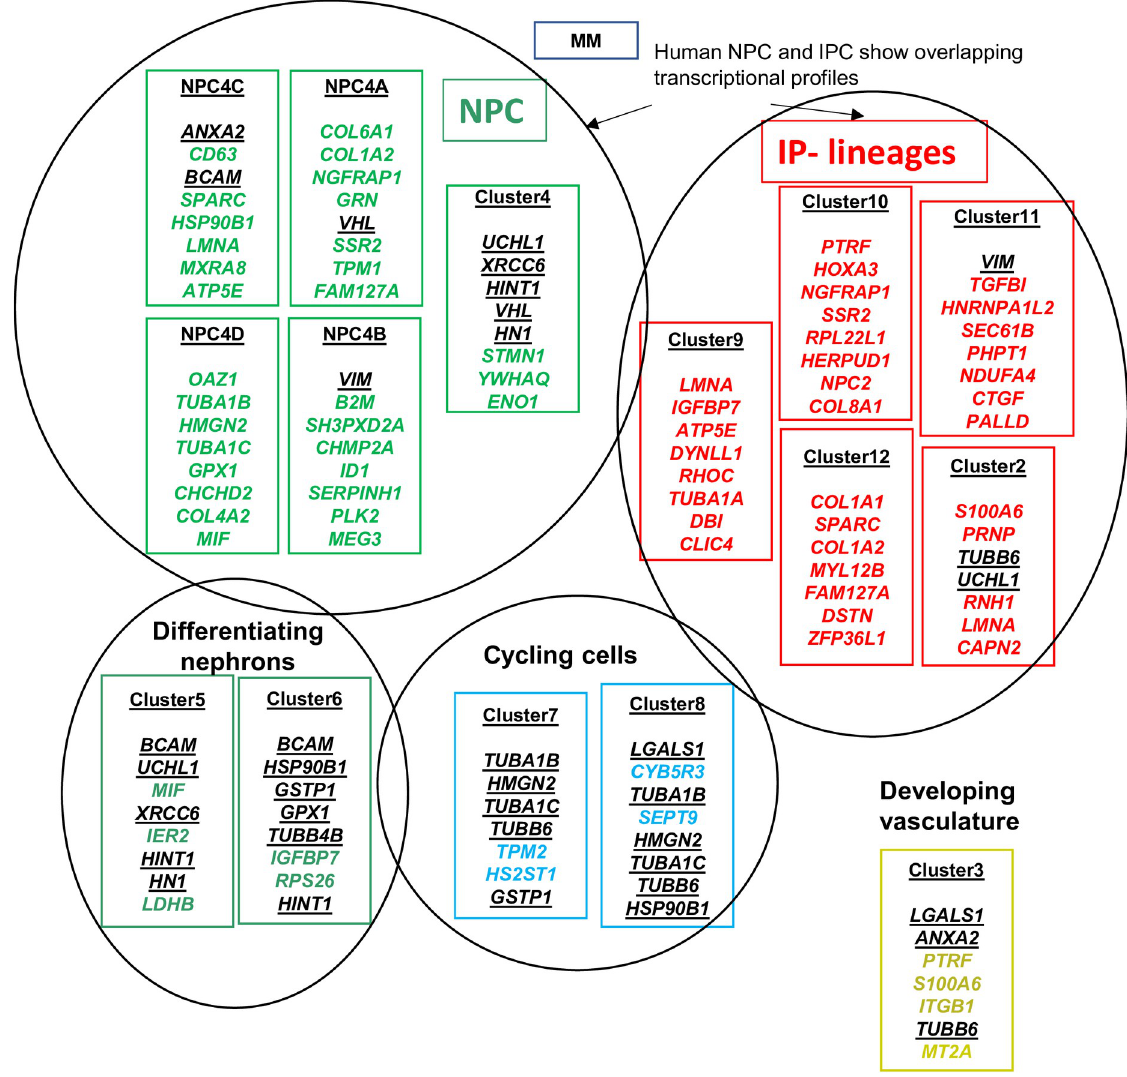
Fig 5. Common expression of genes in Lindstro¨m clusters and Wilms cell lines. First genes that are specific, i.e., only expressed in one cluster were extracted. This was done separately for clusters 4A, 4B, 4C, and 4D from the NPC compartment. Cluster 4 is the parental cluster and is shown in the same circle. The top expressed genes in Wilms cell lines and also expressed in the respective clusters are listed and labeled green if they are unique for this cluster; black and underlined genes are also listed in other compartments. Clusters from the IPC compartment were also analyzed for genes exclusively expressed in the subclusters, shown in the red circle. The top expressed genes in Wilms cell lines also expressed in the respective clusters are listed and labeled red, if they are unique for this cluster; black and underlined genes are also listed in other compartments. The top genes for differentiating nephrons are shown in green and for cycling cells in turquois. Cluster1 (immune cells) is not shown.